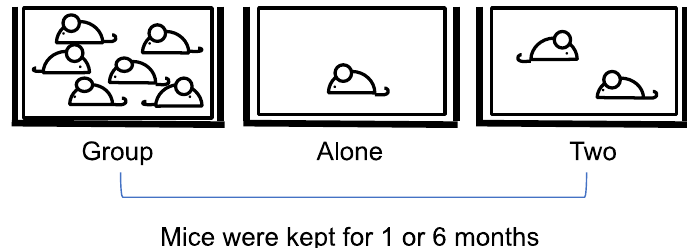
Figure 1. Housing conditions: group, single, and double.